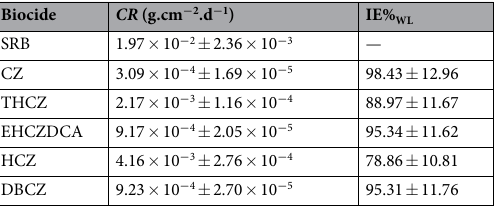
Table 6. The weight loss parameters obtained for mild steel exposed to SRB cultures after 9 days incubation with or without 100 ppm